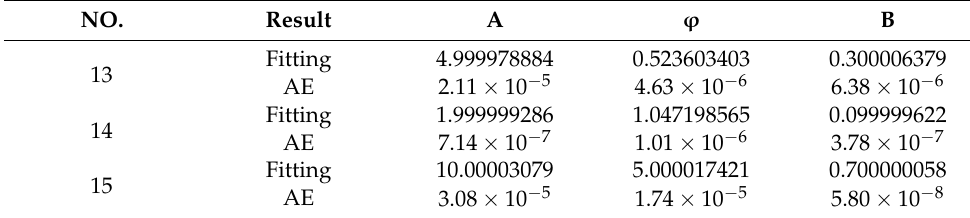
Table 16. Fitting value and absolute error of